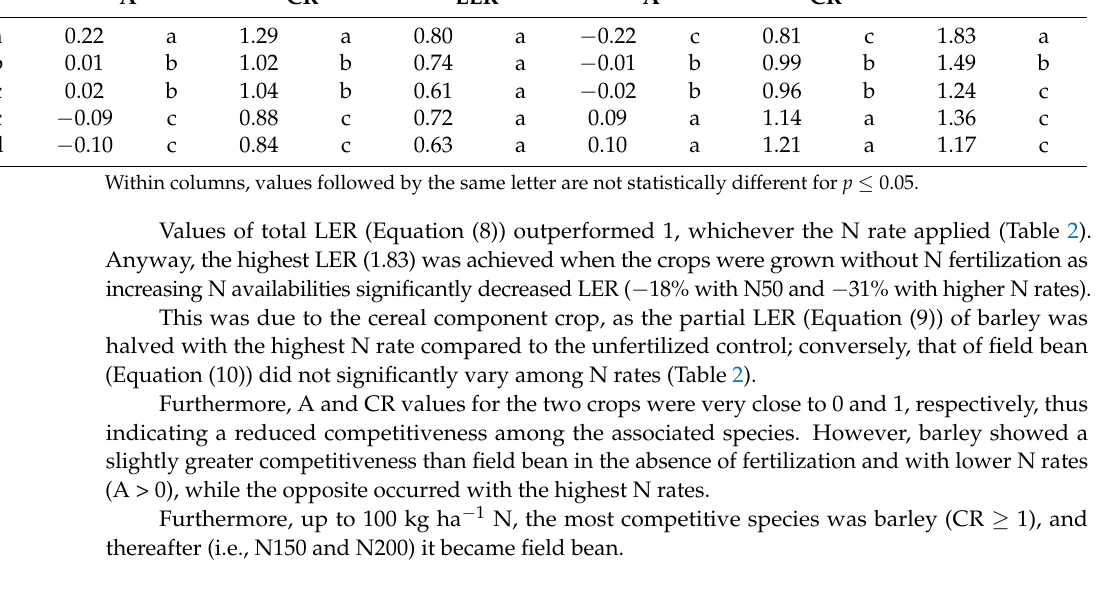
Table 2. Nitrogen rate main effect on partial land equivalent ratio (LER), competitive ratio (CR), and aggressivity index (A) of barley and field bean and on total LER for forage production. Barley Field Bean N